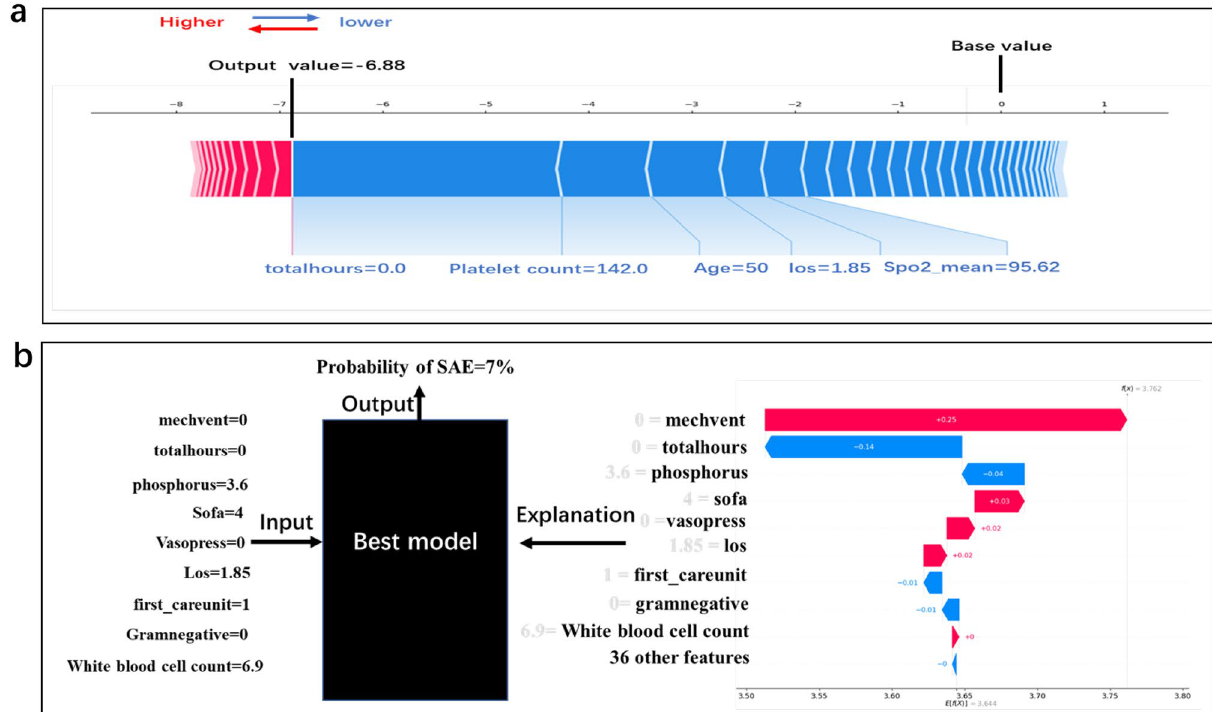
Figure 5. Prediction and interpretation of result for a single sample. ( a ) Characteristic SHAP value influence diagram of a single sample. ( b ) Model prediction diagram and explanation for individual.